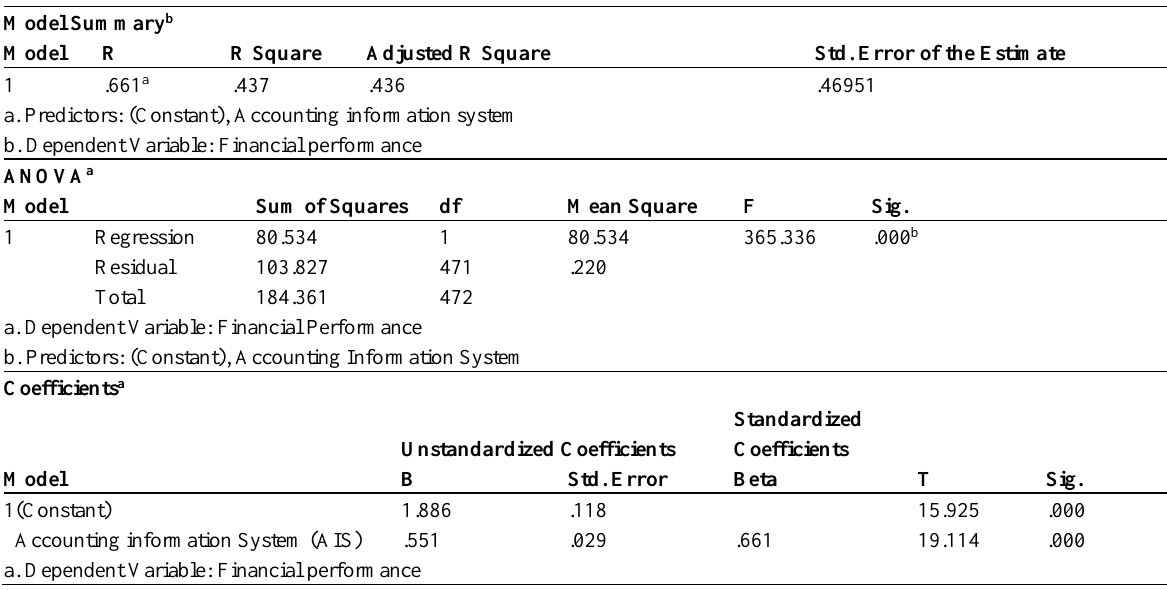
Table 4: Regression Analysis of Independent Variable and Financial